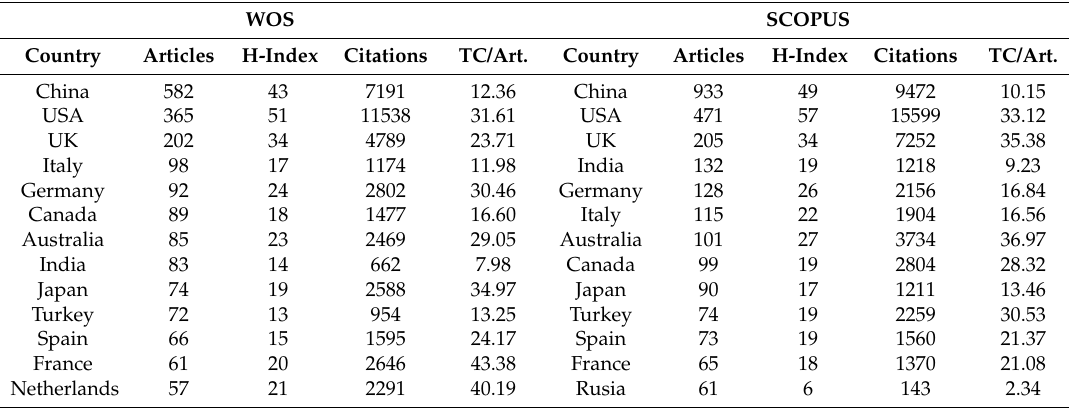
Table 3. Distribution of articles per